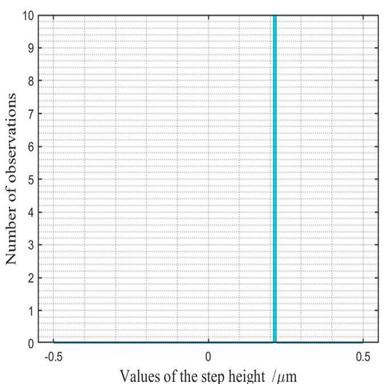
Distributions of the step height values computed by the ISO based method in Experiment 3.